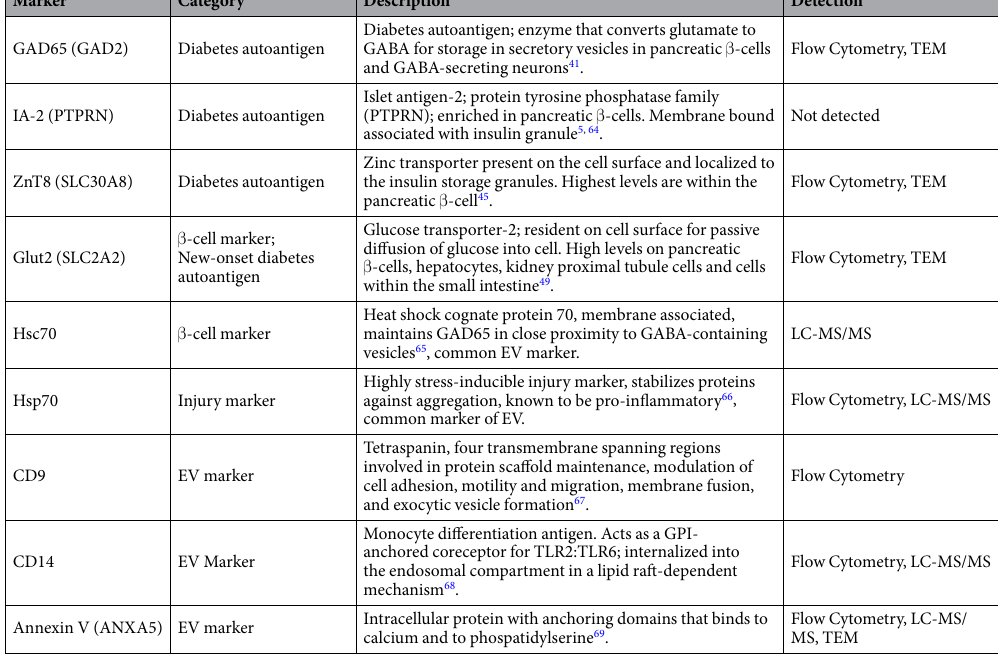
heat shock proteins, clathrin, Rab5C and CD14 (Table 1), confirming that the vesicles detected did in fact con- tain proteins corresponding to transmembrane or lipid-bound, cytosolic and intracellular compartmental origins (Fig. 5a,b). The presence of proteins from mitochondria and lysosomes suggest that the islets might be undergo- ing autophagy and cell death, as has been reported after the mechanical and physical stress during the isolation procedure 32, 33 . Apoptotic Exo-like vesicles from ischemic or stressed cells are known to stimulate autoantibody production, as is the case for the serum-starved HUVEC used to compare with that of our fractionated ICM EV data set 13 . The EV we have detected in human ICM may also contribute to the stimulation of an inflammatory